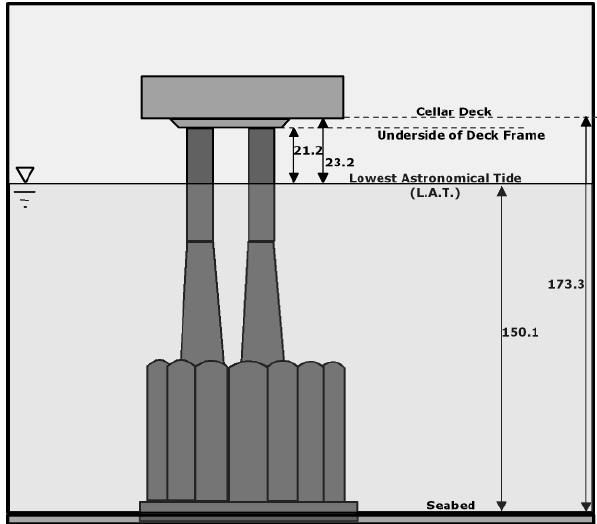
Figure 6. Schematic illustration of the GBS with key data, original condition (full scale) [8].